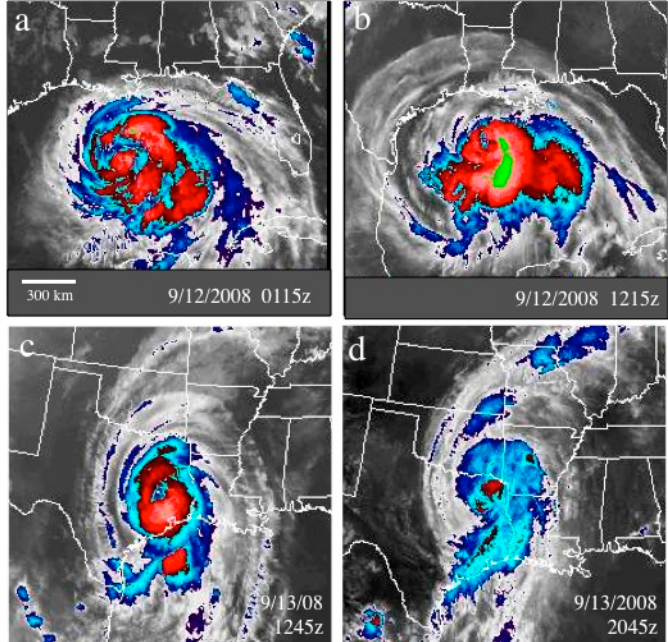
Figure 5. Evolution of Hurricane Ike, a destructive hurricane that rapidly lost strength after making landfall near Houston TX at Category 2 strength. Note how the cloud belts expanded and lost tightness as hurricane strength dissipated from panel a to d, with date and time as listed. A morphologically similar evolutionary sequence probably occurs in spiral galaxies. Images are publicly available from NOAA [48], all at the same scale.